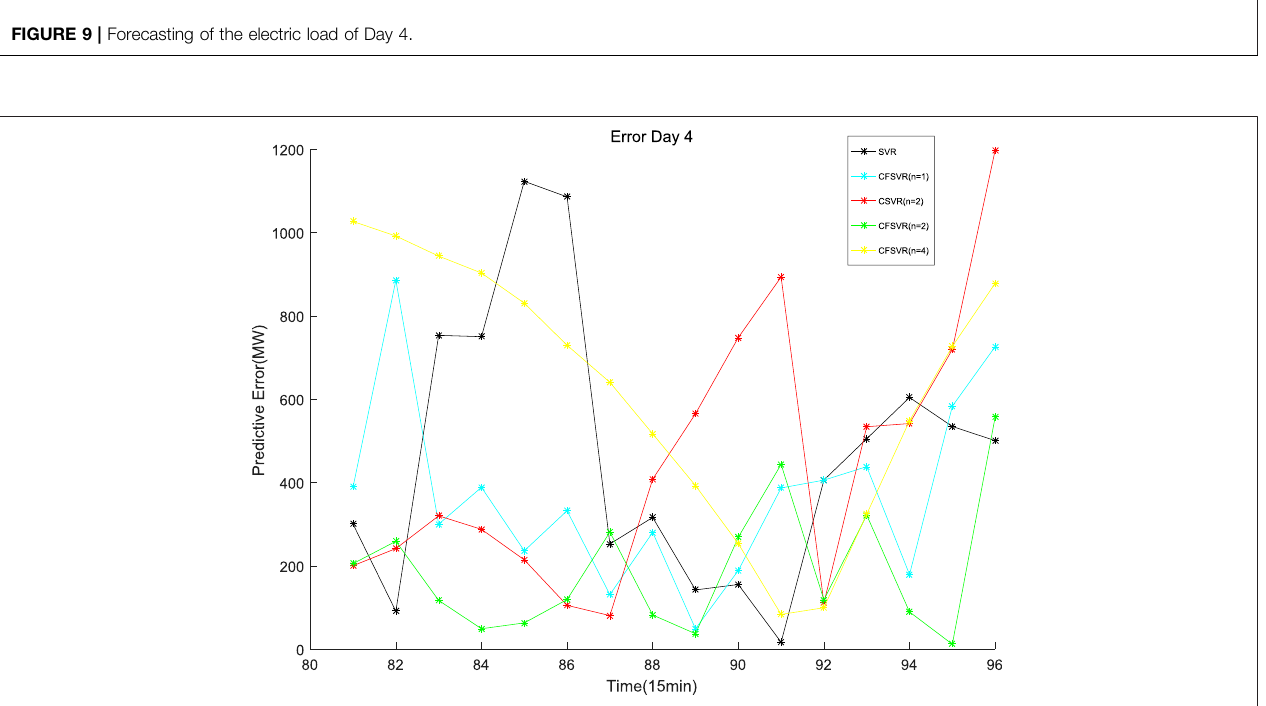
FIGURE 10 | Error of electric load forecasting of Day